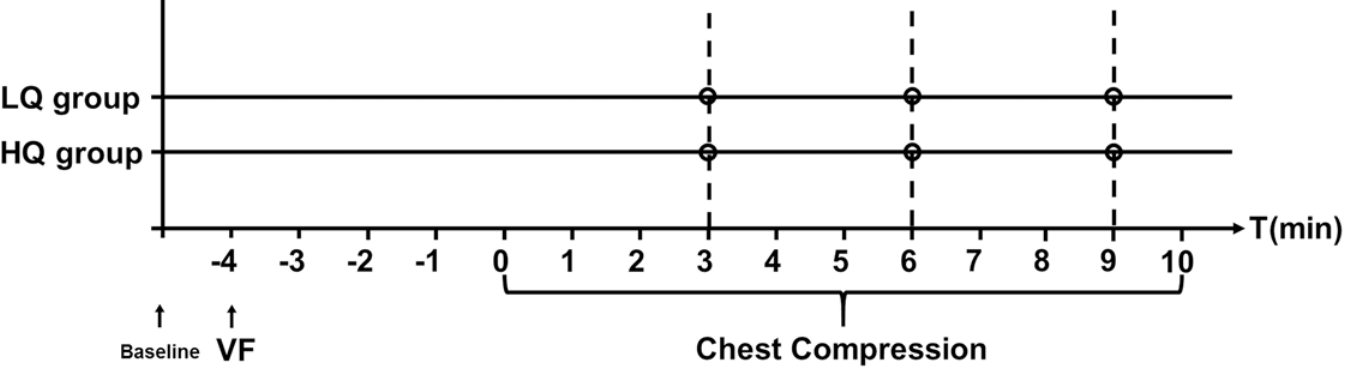
Fig 1. Experimental